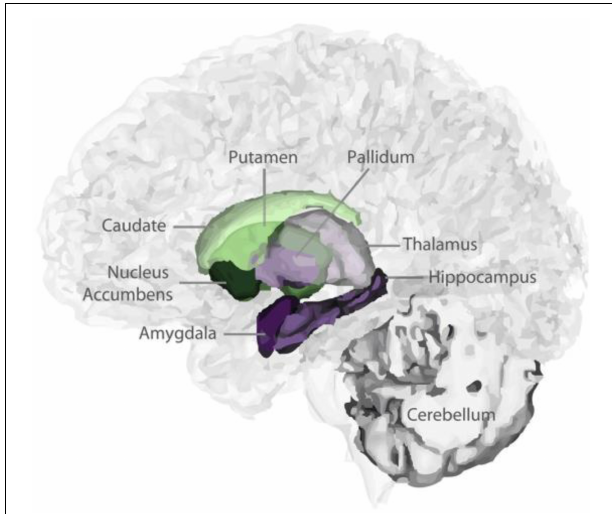
FIGURE 1 | 3D view of subcortical